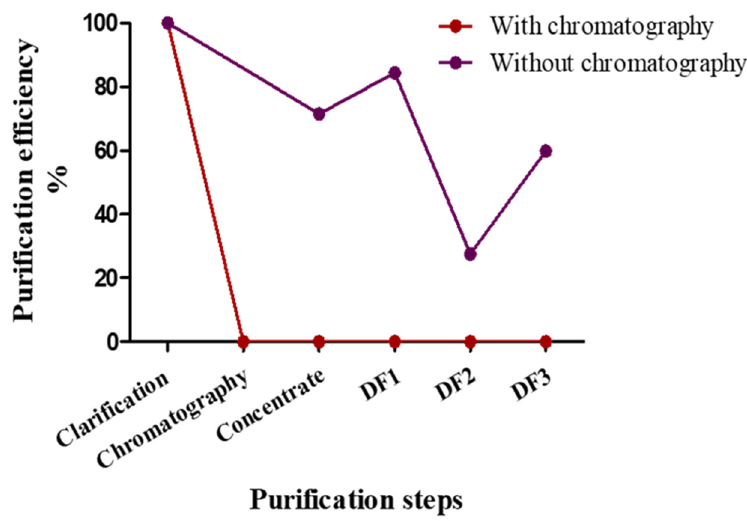
Figure 3. LDH purification profiles in protocol 1 (with chromatography, red line) and protocol 2 (without chromatography, purple line). LDH was measured in each step of the DSP. The initial concentration was set as 100% and all the others were normalized accordingly. Table 1. HCP purification efficiencies in the DSP with and without chromatography.